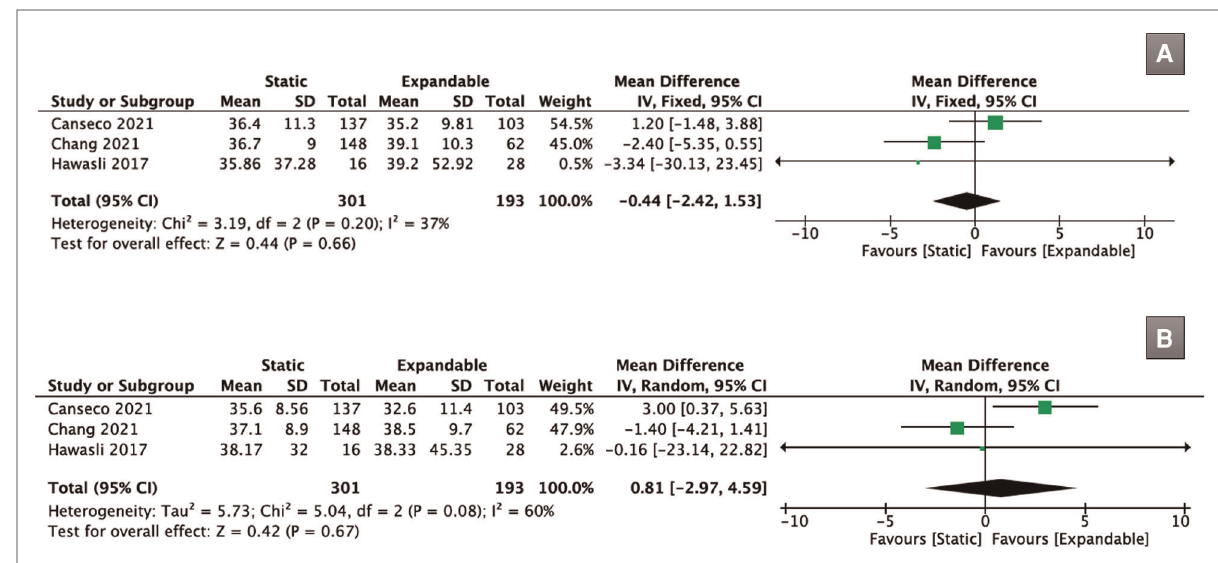
FIGURE 7 Forest plots for comparison of SS at preoperative ( A ) and fi nal follow-up ( B ) between the static and expandable groups. SS: sacral slope.